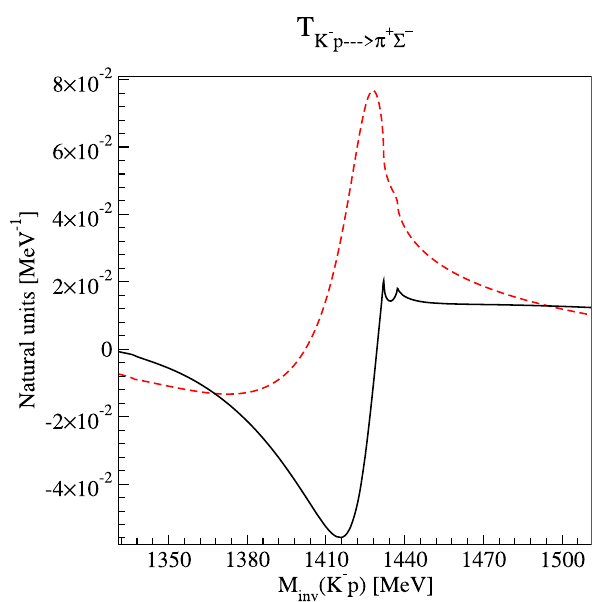
Fig. 9 Energy dependence of the real (dashed line) and the imaginary (solid line) parts of the K − d → p Σ − for the ↑↑→↑↑ spin transition (leftpanel)and K − p → π + Σ − (rightpanel)amplitudes.The K − p → π + Σ − amplitude is taken from the model Oset-Ramos